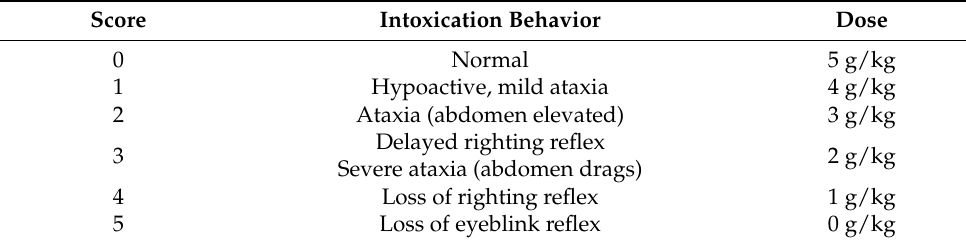
Table 1. Intoxication behavior scale and dosing.